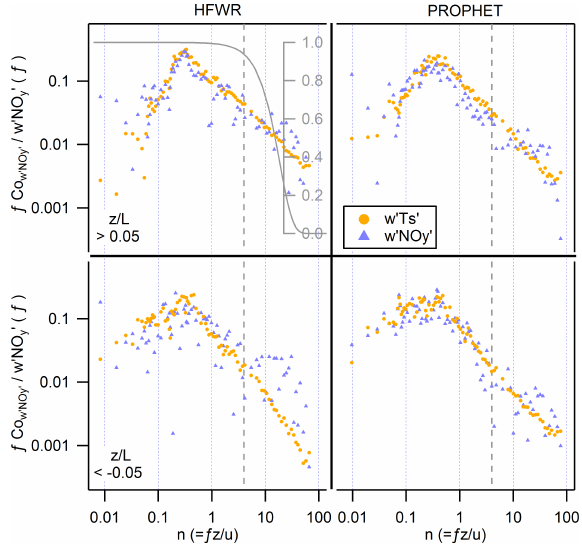
Fig. 5. Normalized cospectra of w 0 NO y 0 for HFWR and PROPHET (left and right panels respectively) separated into stable and unstable conditions (top and bottom panels respectively). The solid grey line in the top left panel represented the tube-attenuation coefficient as calculated by Eq. 3. See text for further